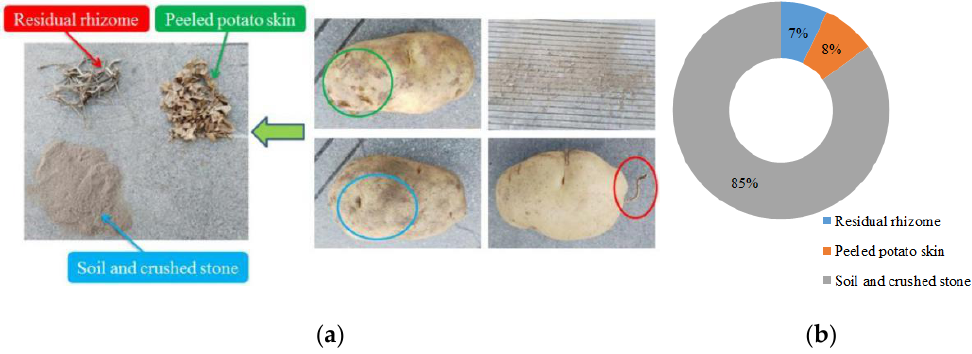
Figure 11. Type and proportion of impurities in potato tubers. ( a ) Type of impurities; ( b ) Proportions of impurities.